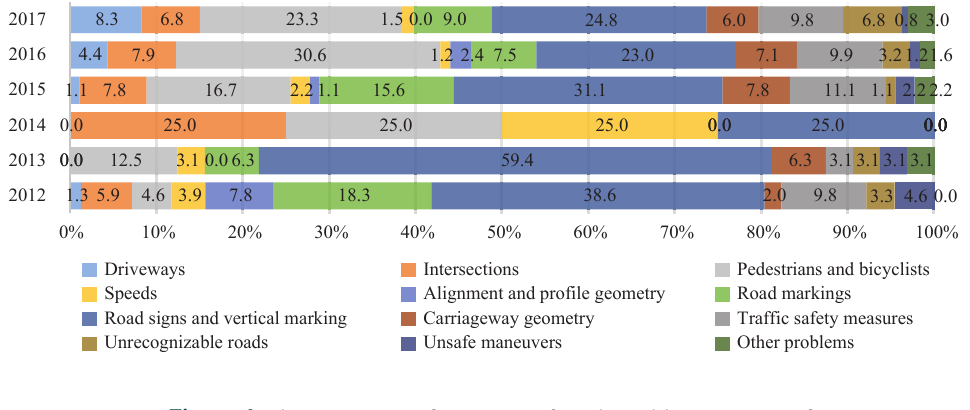
Figure 6. The occurrence frequency of each problem category for transit